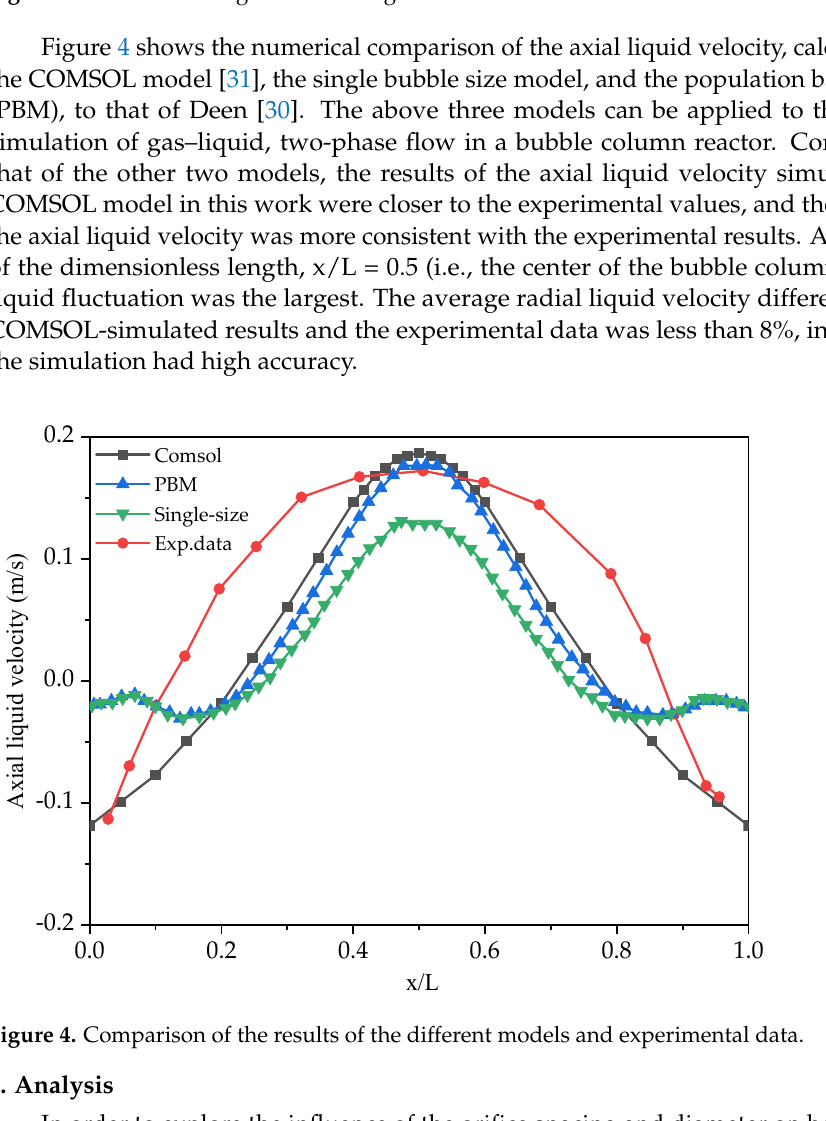
Figure 3. Simulated unit geometric and grid model for verification.